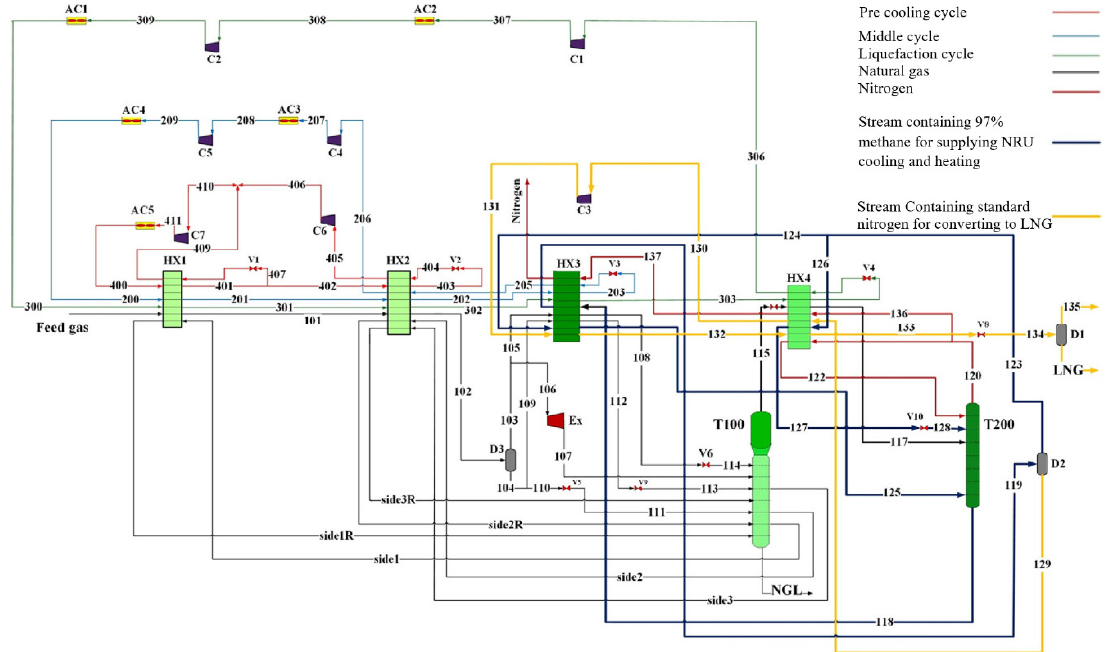
Energies 2022 , 15 , 7895 12 of 61 Figure 10. Process flow diagram of MFC-NGL-NRU [49]. Reproduced with permission from Elsevier Figure 10. Process flow diagram of MFC-NGL-NRU [49]. (license number 5413341375464).